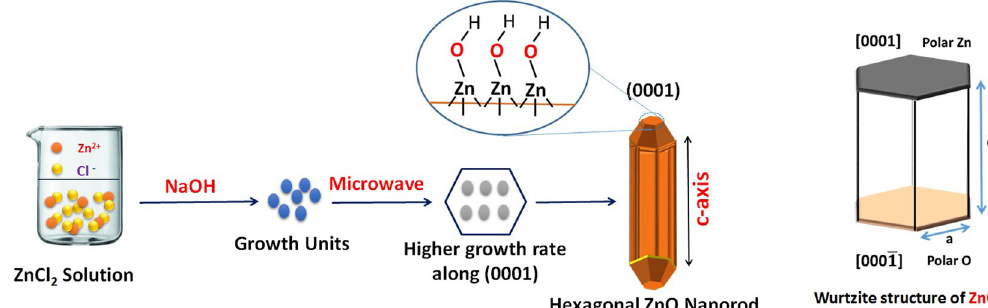
Figure 4. Growth mechanism of ZnO nanorods.